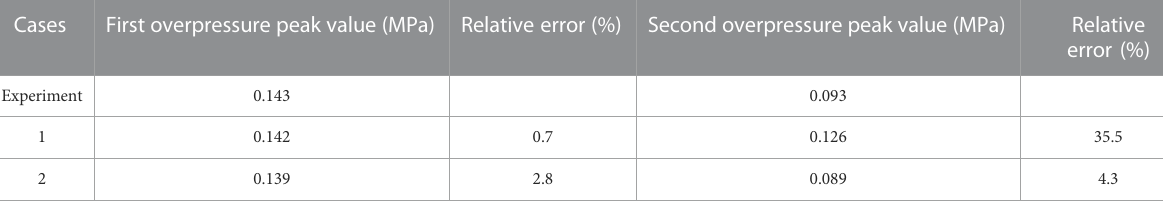
TABLE 1 Results of the experiment and simulation with the explosive-driven method. Cases